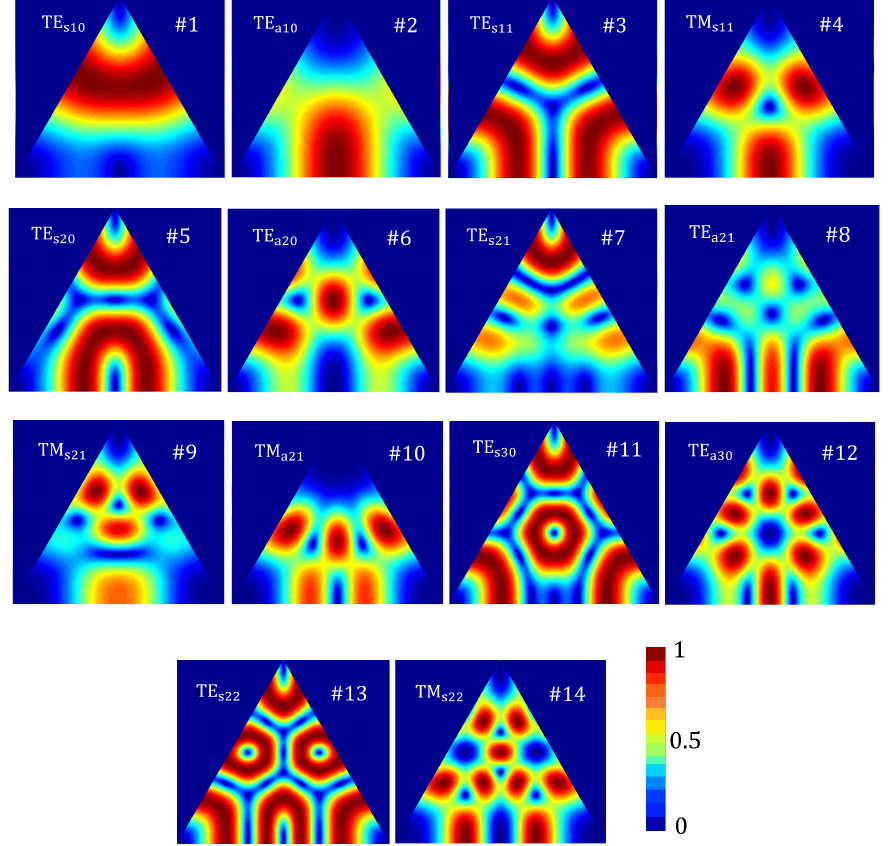
Figure 2. Normalized magnitude of the tangential modal functions in the equilateral triangular